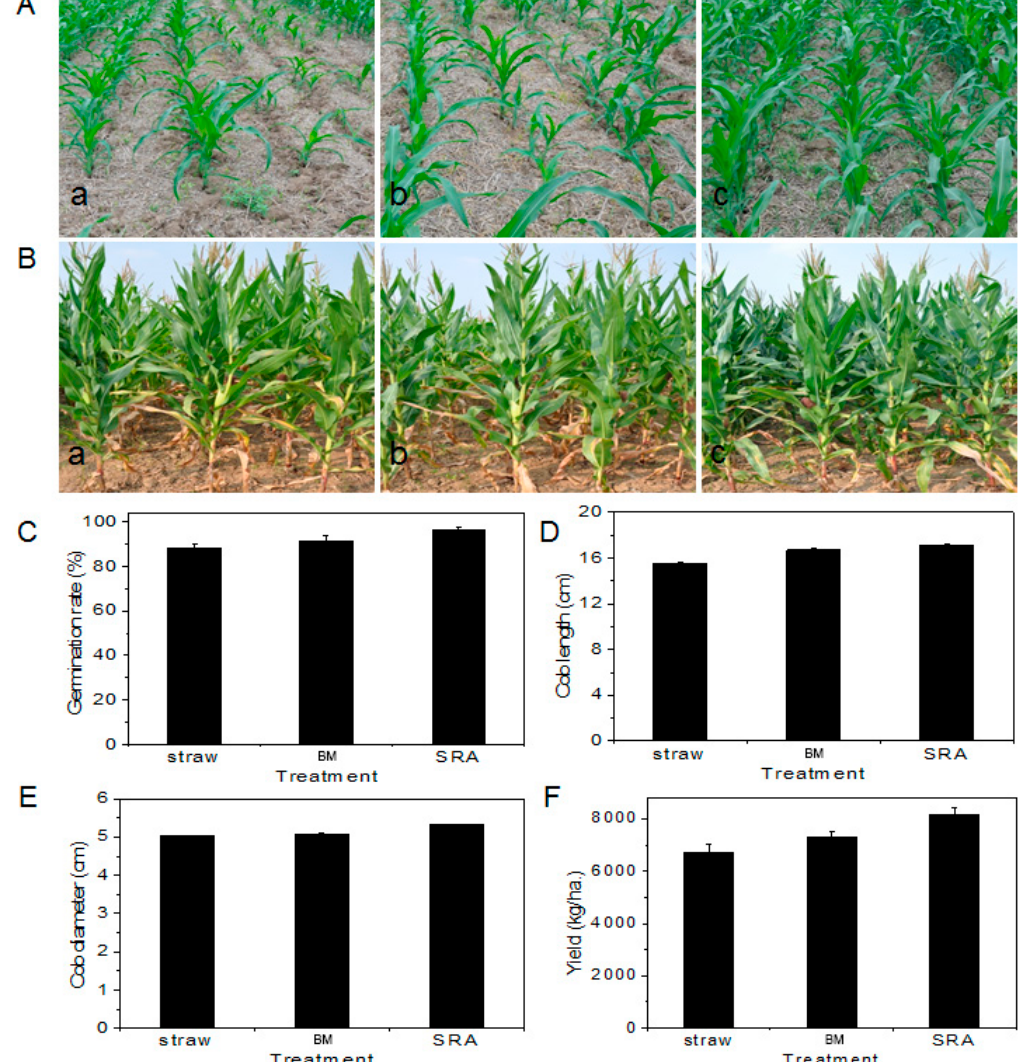
Figure 4. Digital photographs after seeding for 20 ( A ) and 80 d ( B ), respectively, of wheat straw alone ( a ) and those treated by ( b ) BM and ( c ) SRA. ( C ) germination rate, ( D ) Cob length, ( E ) cob diameter, and ( F ) yield of maize in fields (100 m 2 ).